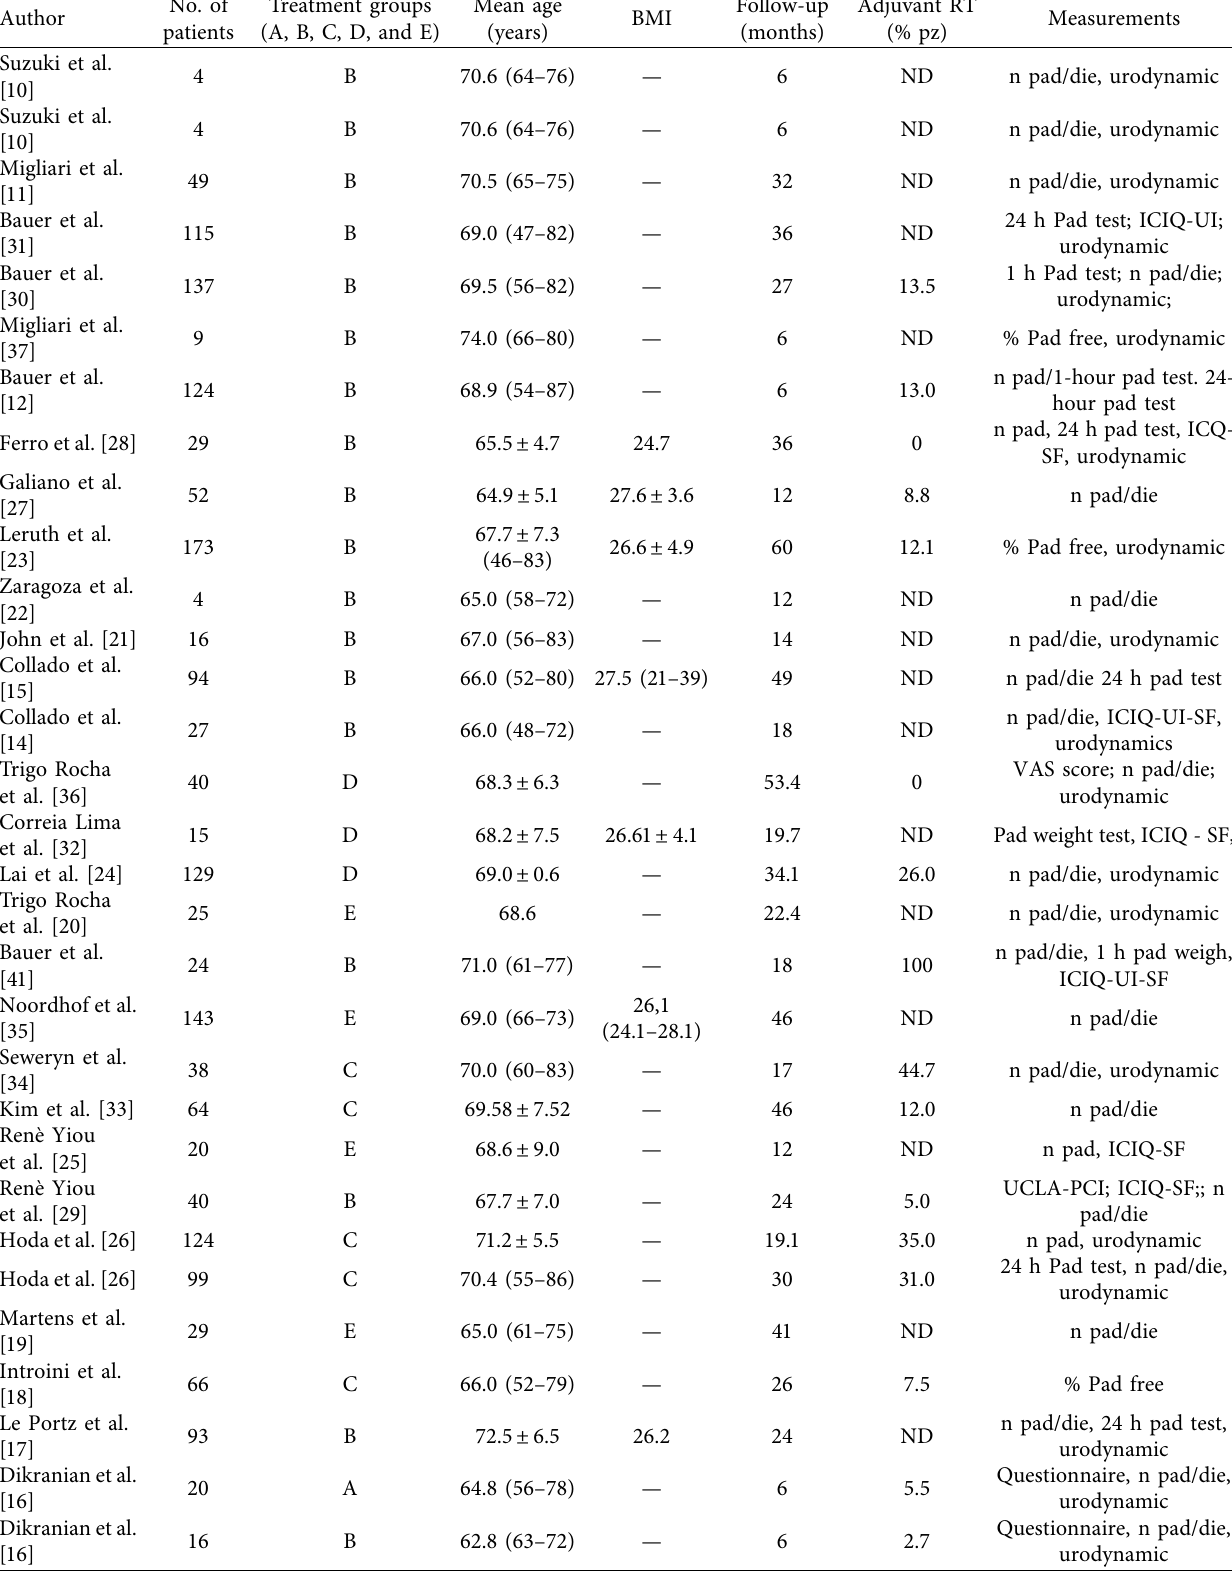
Table 2: 36 prospective clinical trials included in the analysis: main characteristics of the population. Number of cases; mean ± SD or median and